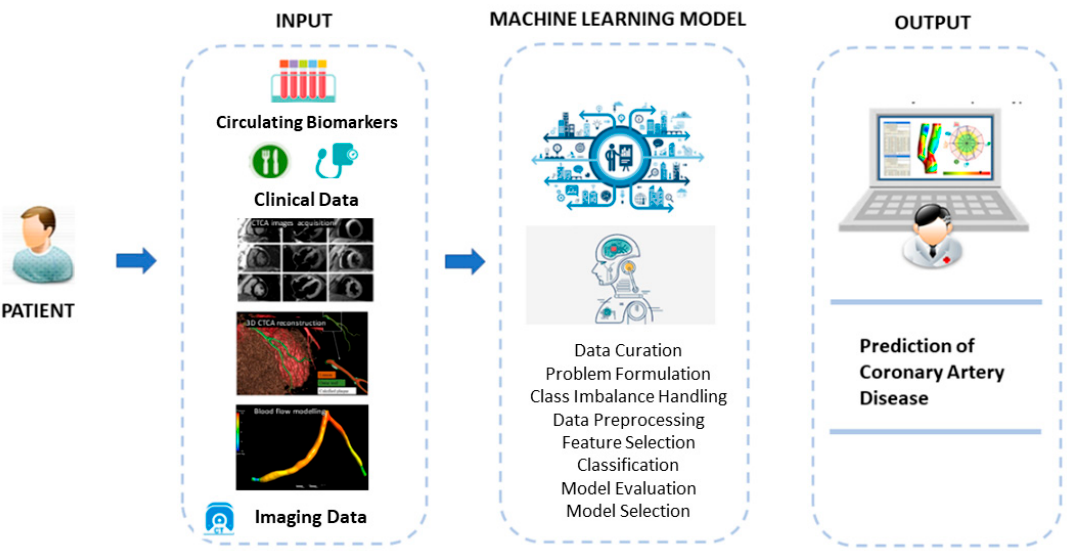
Figure 2. Overall pipeline of the proposed methodology. The input is based on clinical data, laboratory test, and imaging data provided by the three-dimensional reconstruction of the artery and the blood-flow modelling. Different machine learning models were implemented for the prediction of coronary artery disease presence.